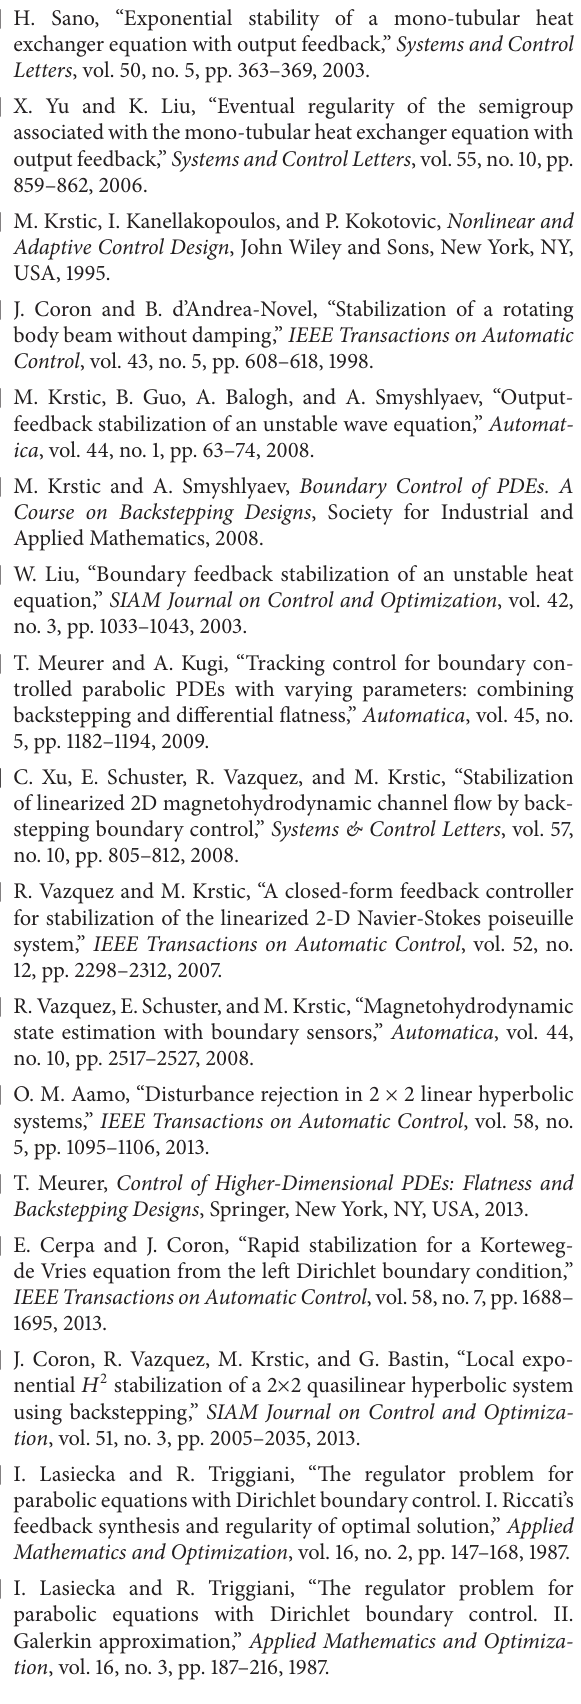
Figure 13: The shape function 𝑔(𝑥) for different 𝛾 ( 𝛾 = 4.5, 5, 6, 7 ).